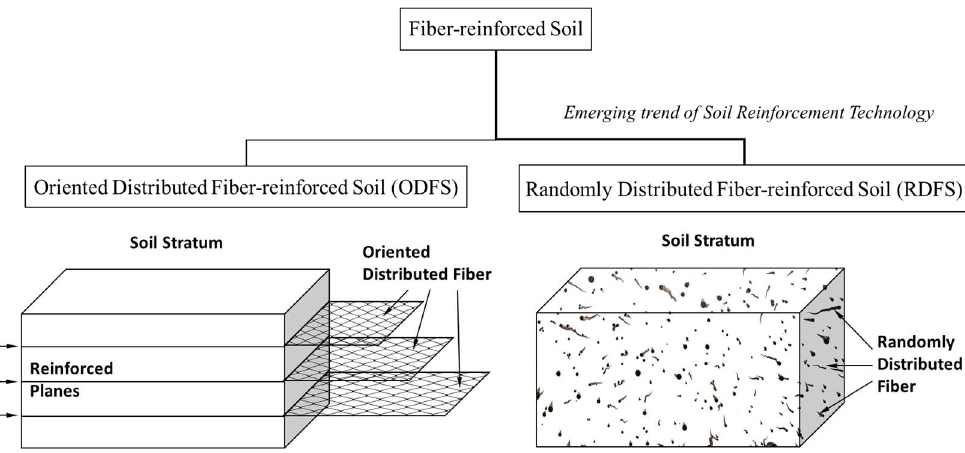
Figure 4. Classification and illustration of Fiber reinforcement mechanism of soil.